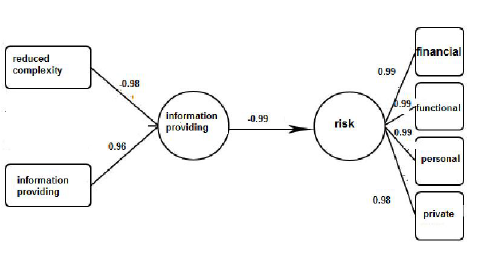
Fig. 5. The results of testing the third